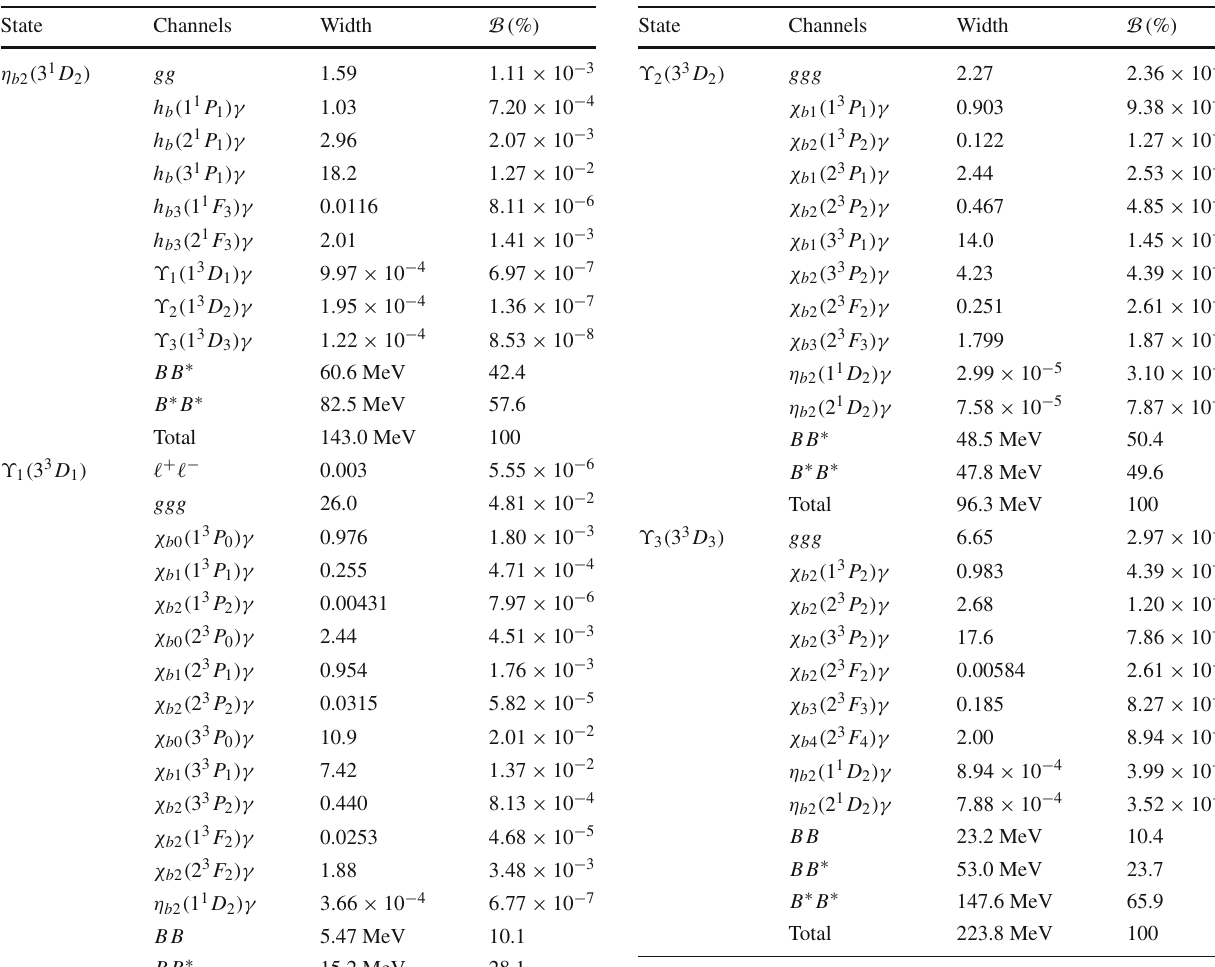
Table 27 Partial widths and branching ratios of OZI-allowed strong decay, annihilation decay, and radiative transition and total widths for 3 1 D 2 and 3 3 D 1 bottomonium states. The width results are in units of